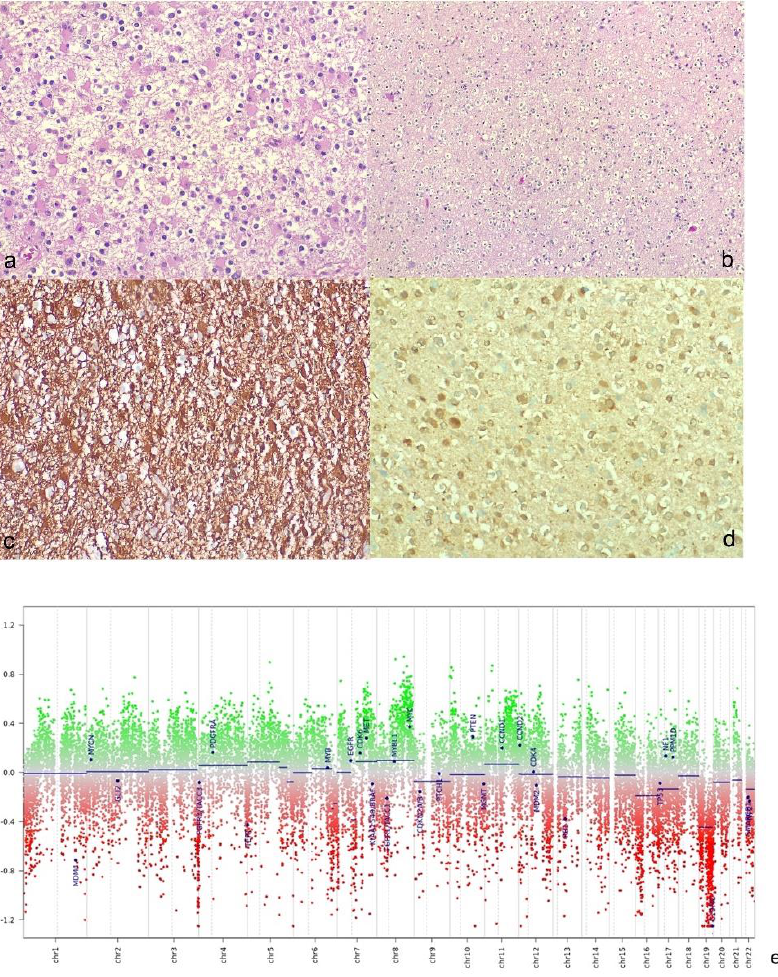
Figure 3. Histologic and immunohistochemical studies. ( a ) Neoplasm with fibrillary background, composed of mildly pleomorphic cells having hypercromic and eccentric nuclei and dense cyto- plasm with “glassy” appearance (gemistocytes) ( Hematoxylin-eosin staining, original magnifyication 20 × ). ( b ) Some fields were oligo-like cells rich ( Hematoxylin-eosin staining, original magnification 10 × ). ( c ) Neoplastic cells were diffusely GFAP positive ( Immunoperoxidase staining, original magnification 10× ). ( d ) The immunohistochemical assessment of IDH1 status revealed an IDH-mutant diffuse gli- oma ( Immunoperoxidase staining, original magnification 20× ). ( e ) Copy Number Variations analysis: The analysis of CNVs showed deletion involved chromosome 19 and partial amplification of MYC.